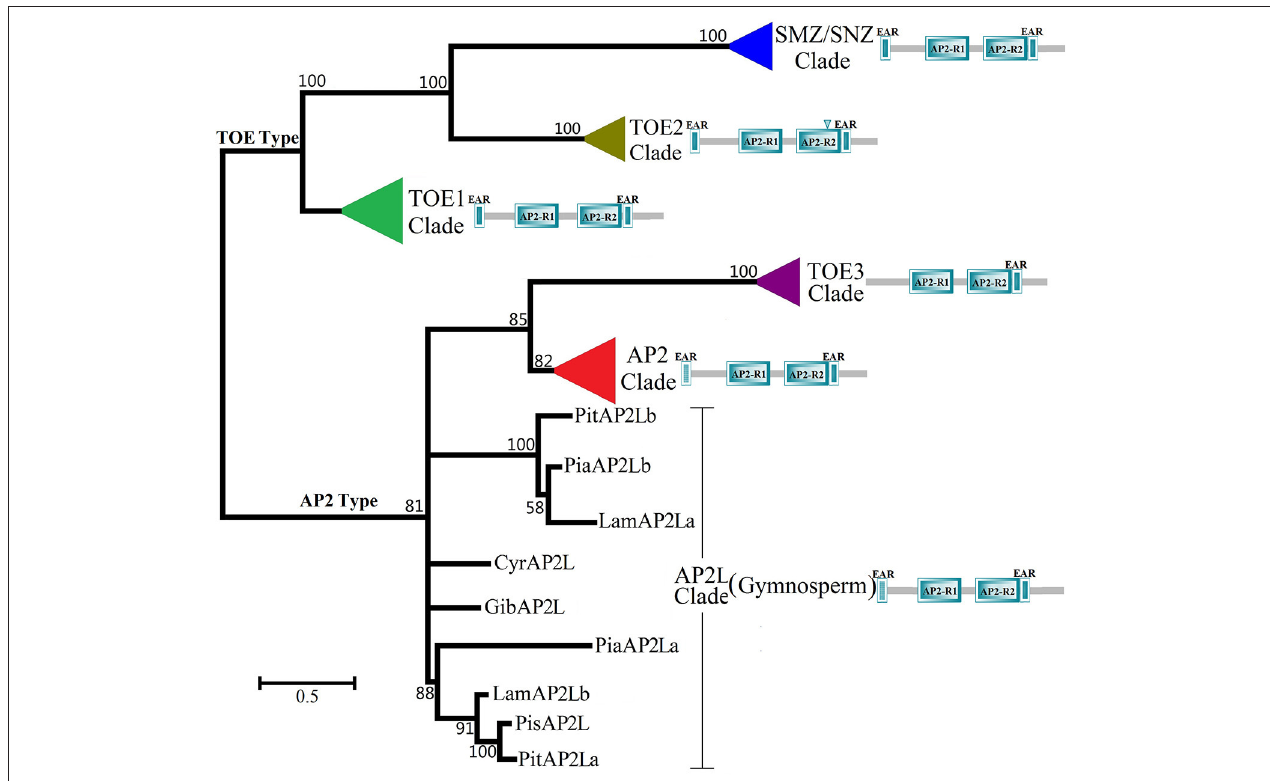
FIGURE 1 | Maximum-likelihood Phylogenetic Tree of AP2 Group Protein in Spermatophyte (simplified phylogenetic tree). The ML tree was constructed based on the whole protein sequences of spermatophyte AP2 Group gene using MEGA6.0 with 1000 bootstrap replications and Jones-Taylor-Thornton (JTT) + Gamma Distributed model with Invariant sites model (Discrete Gamma Categories = 5). There were 105 spermatophyte AP2 group genes, which were searched from 23 families, 56 spermatophytes. The different color triangles represent different clades except six gymnosperms (red, AP2 clades; green, TOE1 clade; olive, TOE2 clade; purple, TOE3 clade; blue, SMZ/SNZ clade). The detailed phylogenetic tree of every clade was shown in Image 2 . The scale bar indicates the branch length that corresponds to 0.5 substitutions per site. The species and accession numbers are listed in Data sheet 1 .The abbreviations used are as follows: Pit , Pinus thunbergii ; Pia , Picea abies ; Lam , Larix × marschlinsii ; Cyr , Cycas revoluta ; Gib , Ginkgo biloba ; Pi s, Picea sitchensis